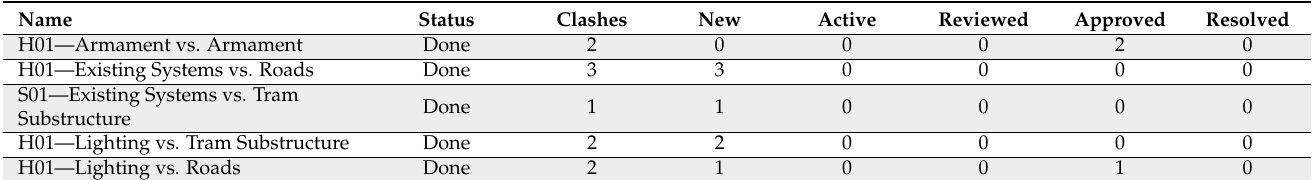
Table 3. Clash Detection activity on Navisworks